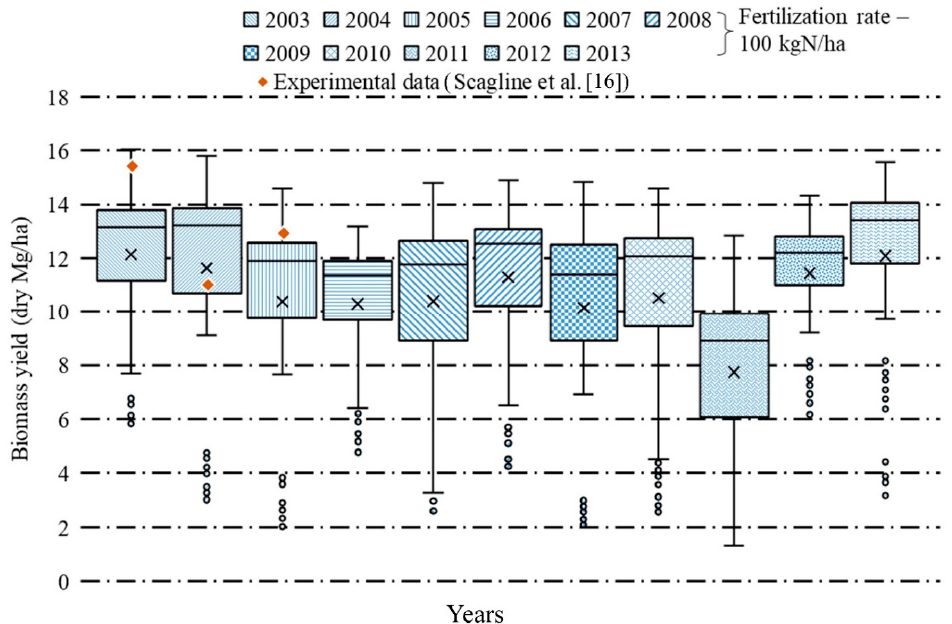
Figure 9. Temporal and spatial variations in annual biomass yield of miscanthus produced from SML (100 kg N ha − 1 and 75 kg P ha − 1 ).